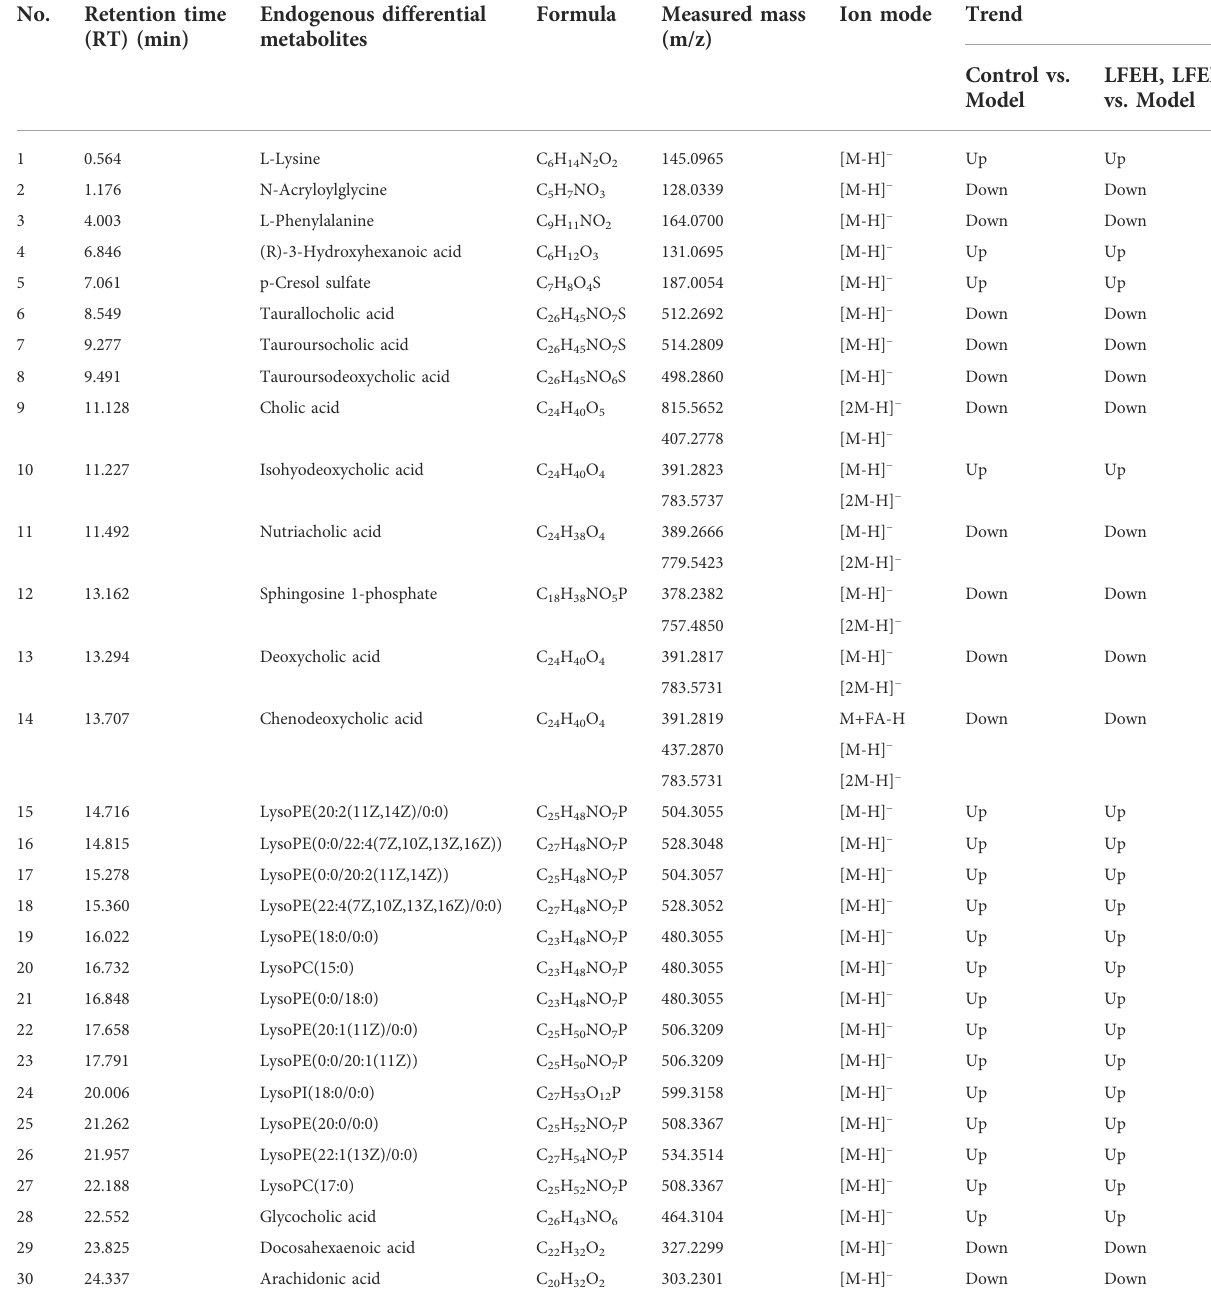
TABLE 3 Endogenous differential metabolites in negative ion